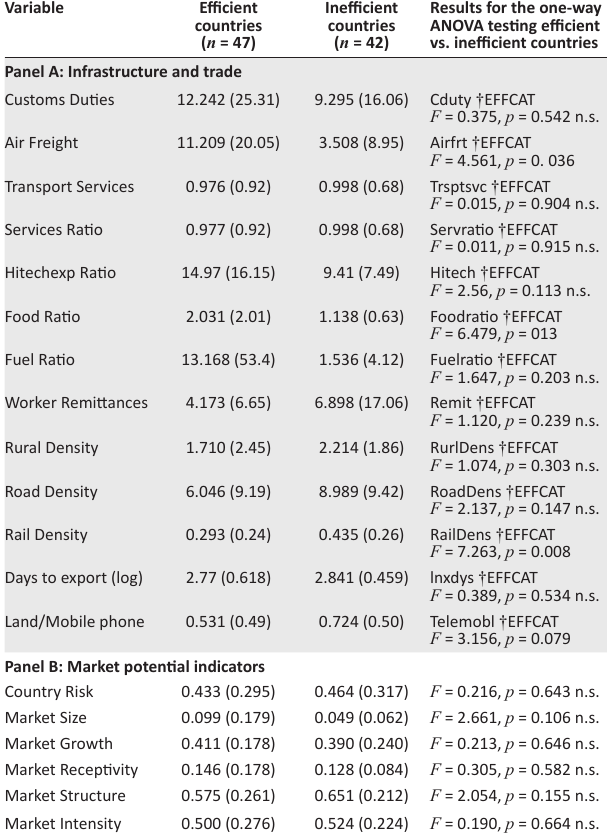
TABLE 3 (Continues...): Country efficiency scores. Country